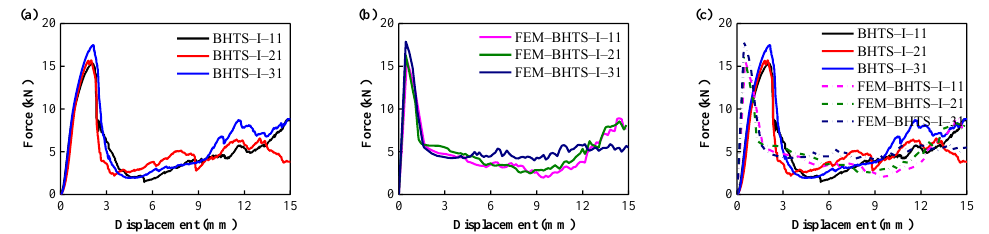
Figure 11. Typical response curves of BHTS – I at each strain rate: ( a ) curves of experimental; ( b ) curves of FEM; ( c ) comparison between experimental and FEM.